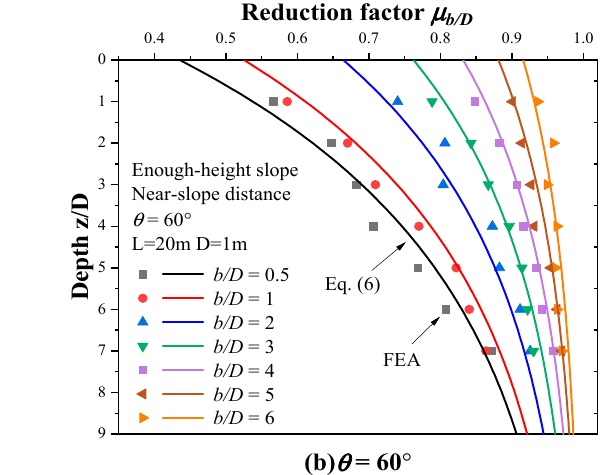
Figure 6. Distribution of non-dimensional parameter 𝛼 .